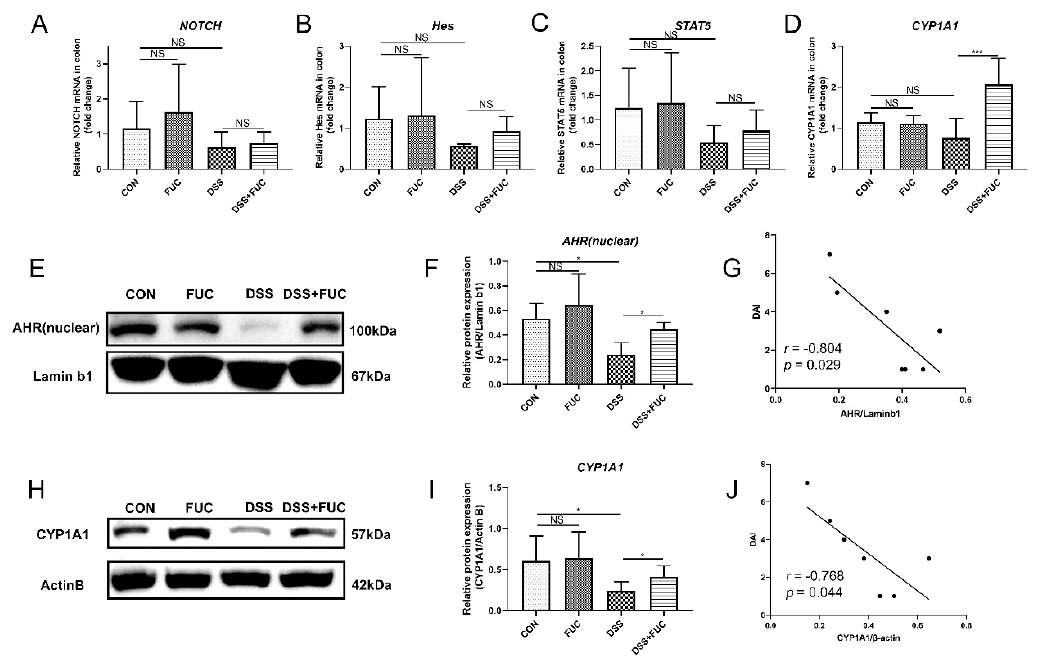
Figure 3. High expression of IL-22-related transcription factors in the colon after L-fucose treat- ment. qRT-PCR analysis of ( A ) NOTCH, ( B ) Hes, ( C ) STAT5 and ( D ) CYP1A1 in the colon. ( E ) Western blotting analysis of AHR protein in the colon nucleus. ( F ) Quantitative analysis of AHR protein in the colon nucleus. ( G ) Correlation analysis between DAI score and AHR protein. ( H ) Western blotting analysis of CYP1A1 protein in the colon. ( I ) Quantitative analysis of CYP1A1 protein in the colon. ( J ) Correlation analysis between DAI score and CYP1A1 protein. Data are expressed as the mean ± SD. * p < 0.05, *** p < 0.001; NS, no significance.